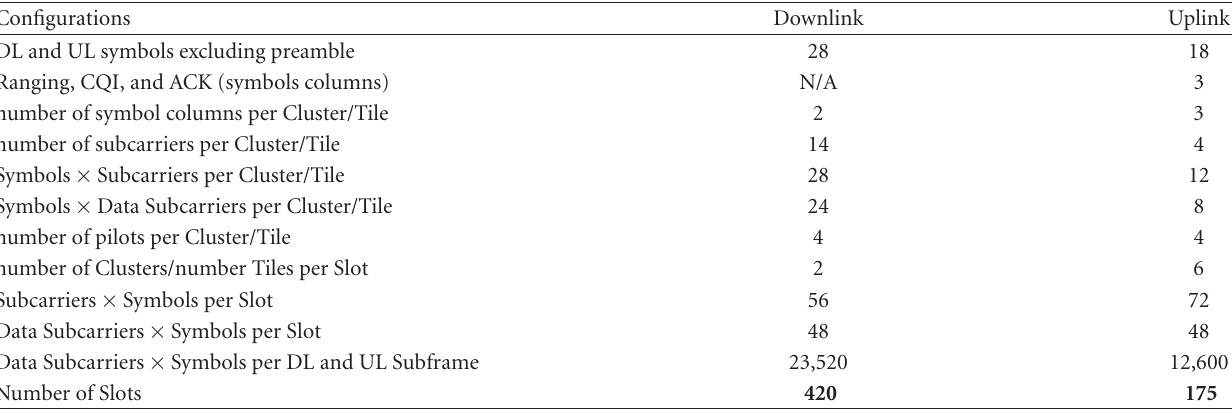
Table 4: Mobile WiMAX system configurations.